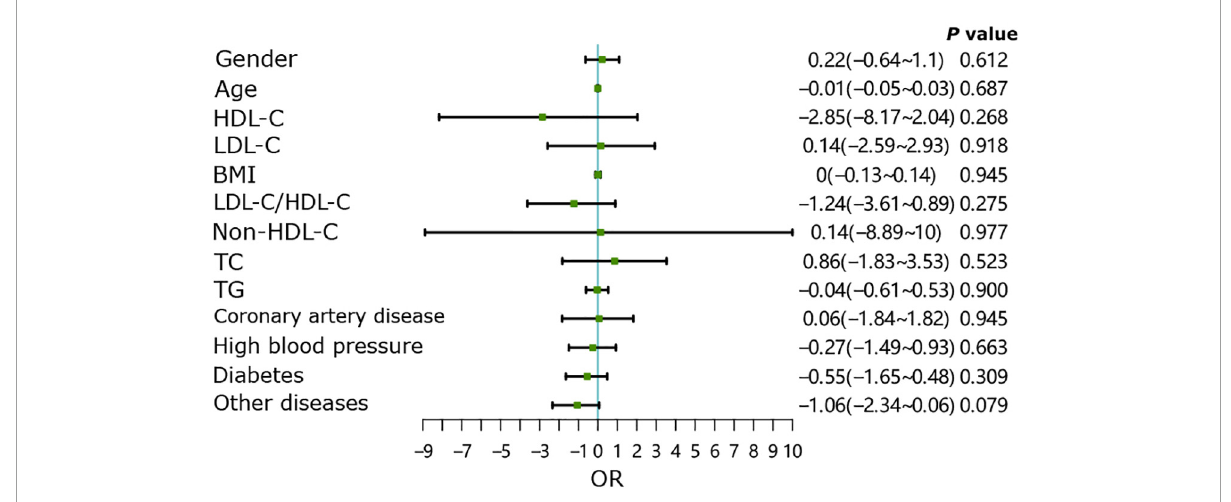
FIGURE7 Contributing factors and endplate inflammation in patients with underlying